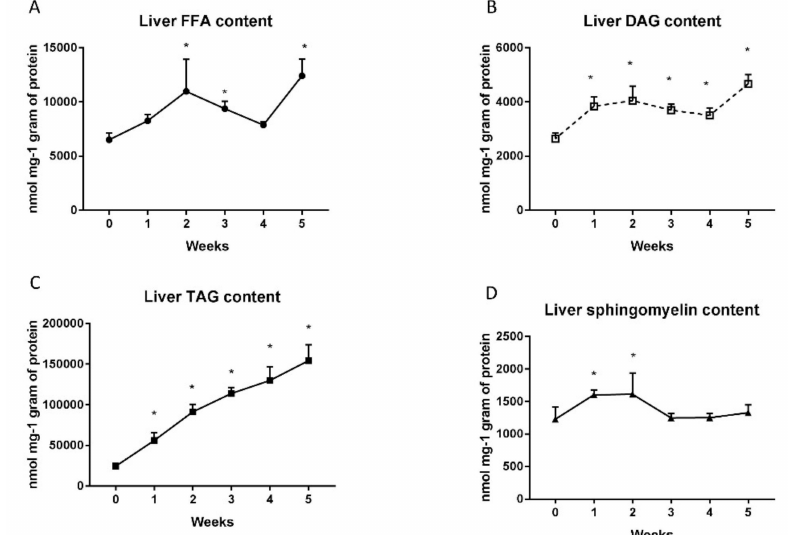
Figure1. Livercontentsoffreefattyacids( A ),diacylglycerols( B ),triacylglycerols( C )andsphingomyelin ( D ) in control group (0 week) and high fat diet (HFD) group at the end of each experimental week (1, 2, 3, 4 and 5). The liver homogenates were prepared as described in detail in the materials and methods section. Total lipid content was measured by the gas-liquid chromatography (GLC) method. The data are expressed as the mean ± S.D. and are based on six independent determinations ( n = 6). * p < 0.05 significant di ff erence vs control group (0